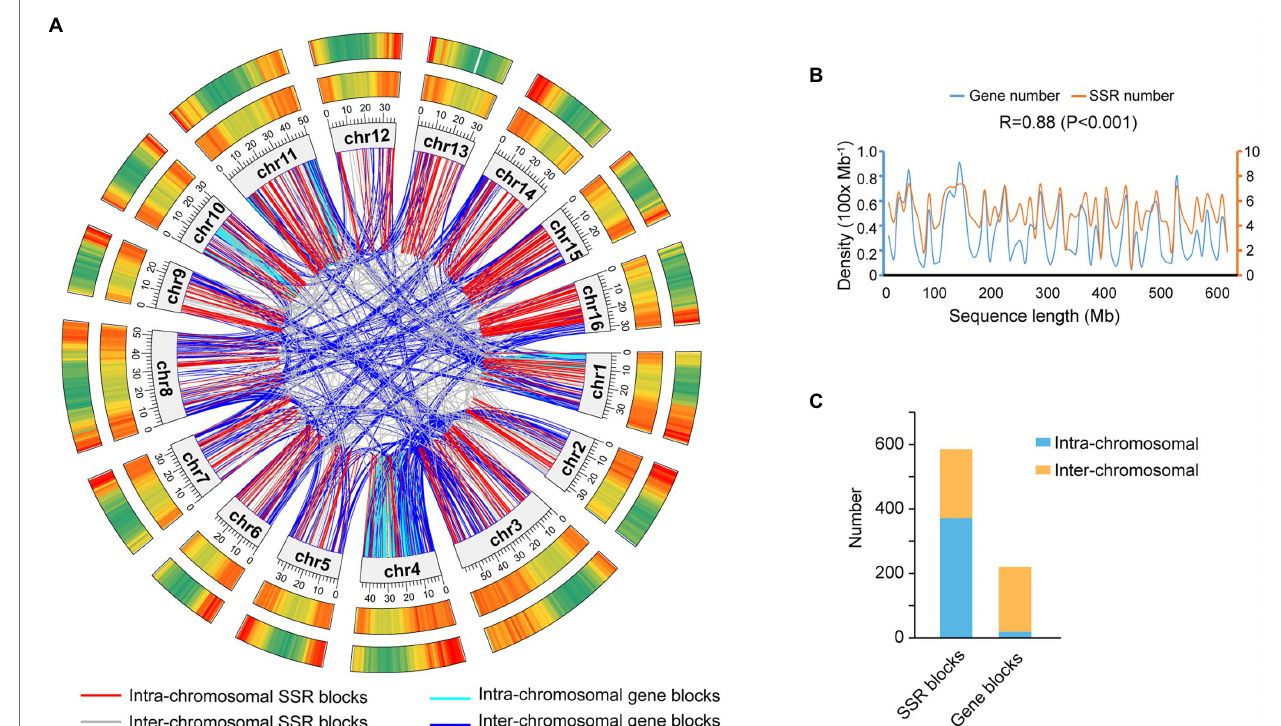
FIGURE 2 | Location and collinearity analysis of SSR loci and genes on the Akebia trifoliata chromosomes. (A) Comparative physical maps of SSR loci and genes, in which the rings from the inner circle to the outer circle show the nucleotide positions on the 16 assembled chromosomes (Mb), gene density, and SSR locus density; the densities are plotted in a 1 Mb sliding window; and gradient colors from green to red in the circles represent the densities from lowest to highest, respectively. (B) Density correlation between gene loci and SSR loci on the 16 chromosomes. (C) Statistical analysis of SSRs and intrachromosomal and interchromosomal gene collinearity blocks.